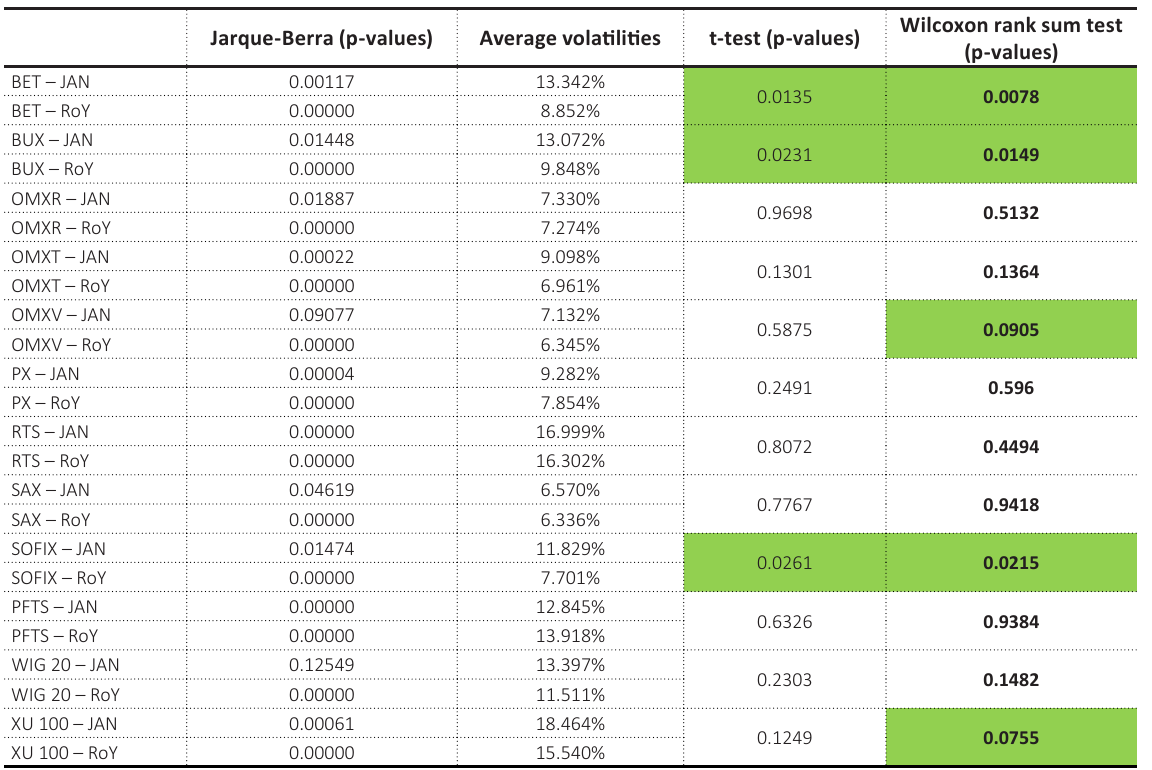
Table 4. January effect statistical significance test results